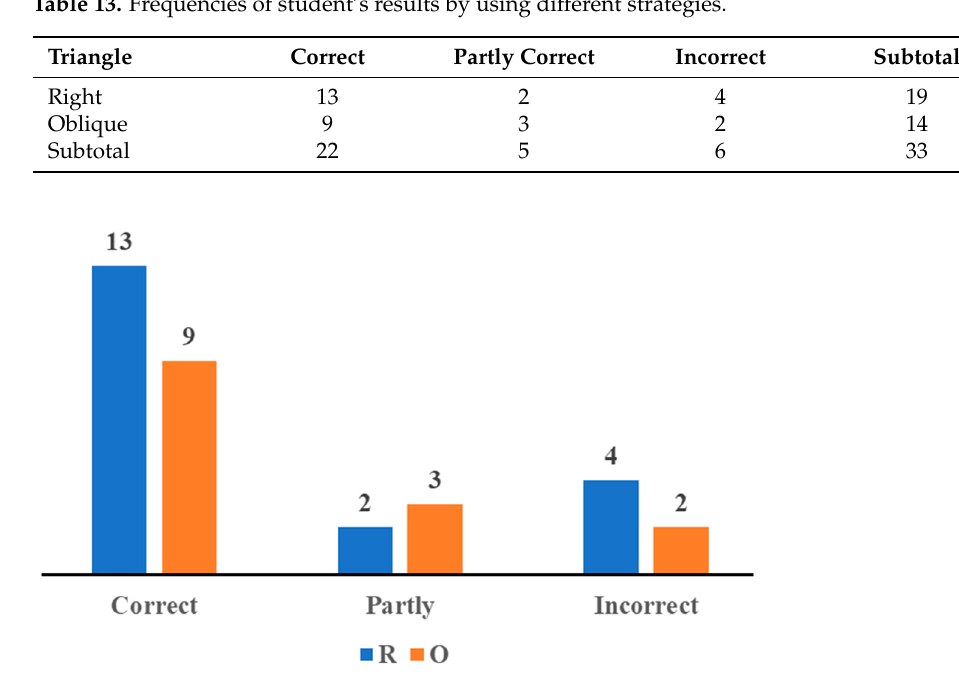
Table 12. Results of chi-test on student’s results and actions from the two gender groups.